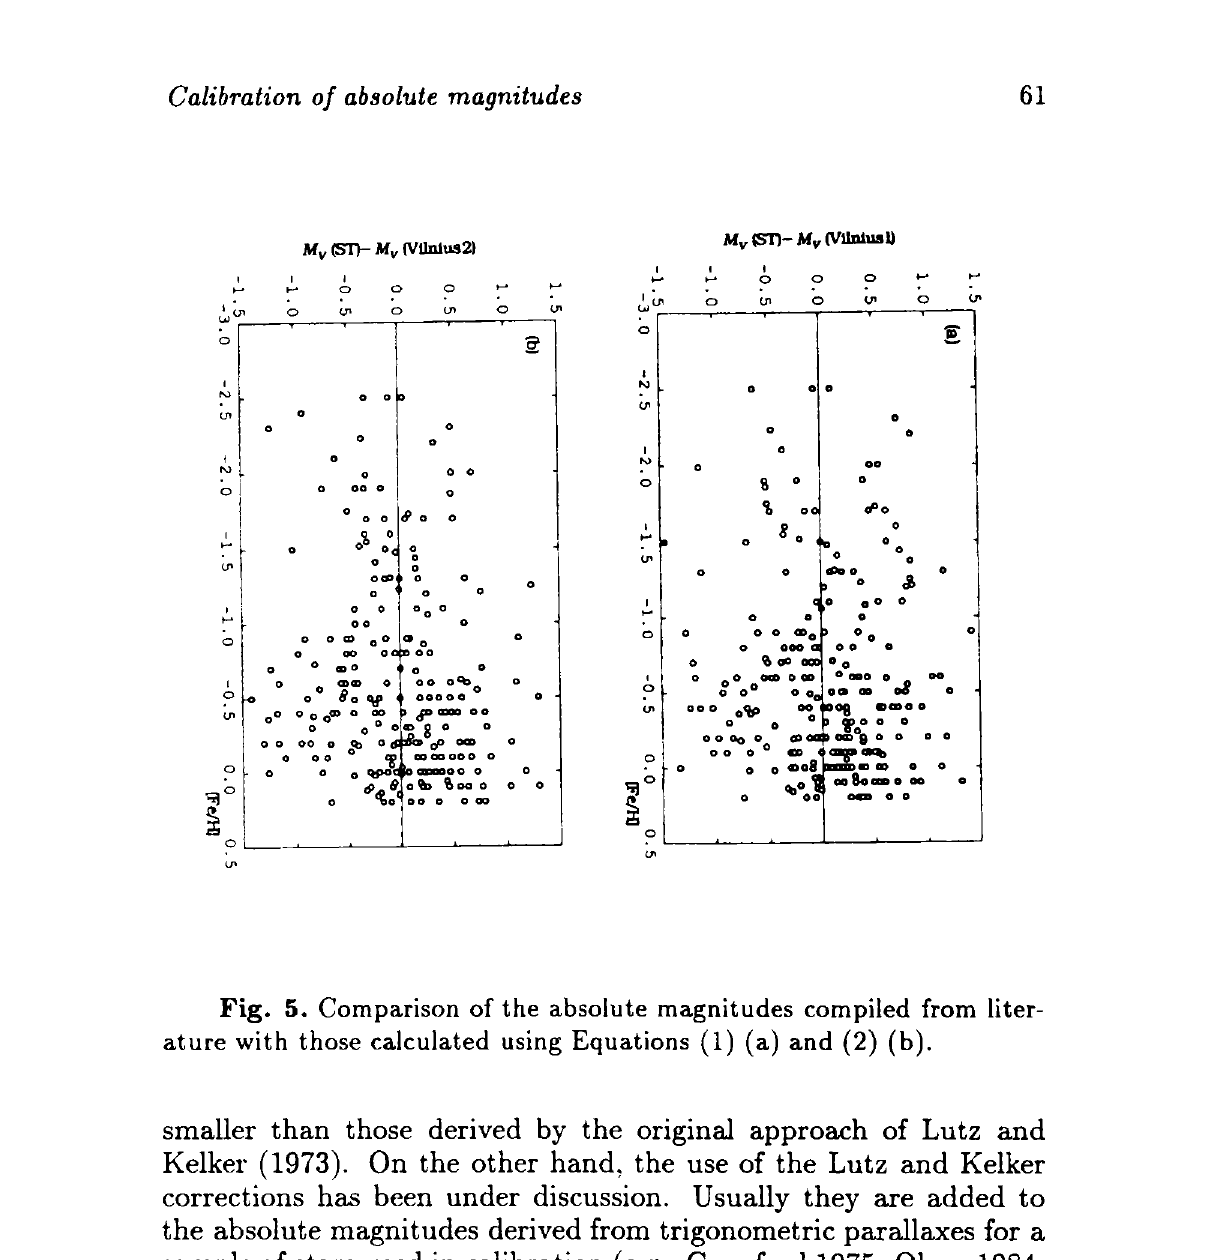
Fig. 5. Comparison of the absolute magnitudes compiled from liter- ature with those calculated using Equations (1) (a) and (2)